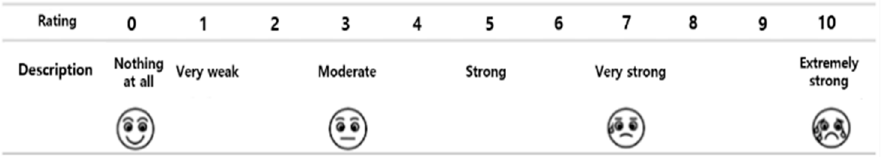
Figure 2. Borg CR10 scale for mental workload ratings.